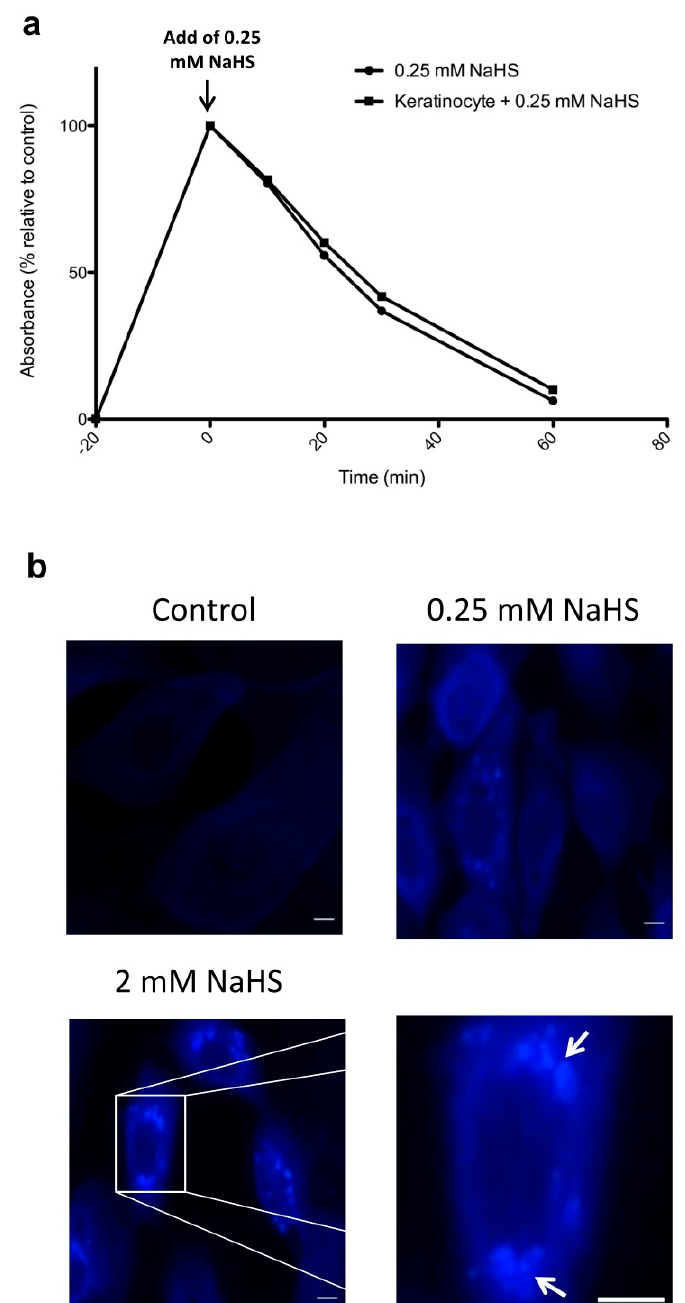
Figure 1. NaHS induces the extracellular and intracellular accumulation of H 2 S in human keratinocyte cultures. ( a ) Kinetics of H 2 S accumulation in keratinocyte culture medium following addition of 0.25 mM NaHS in the presence or absence of cultured keratinocytes. ( b ) The use of a fluorescent H 2 S probe allowed detection of H 2 S accumulation (arrows) in the cytoplasm of cultured keratinocytes stimulated with NaHS at a concentration of 0.25 or 2 mM. Results are representative of three to five experiments. Scale bar: 0.01 mm.